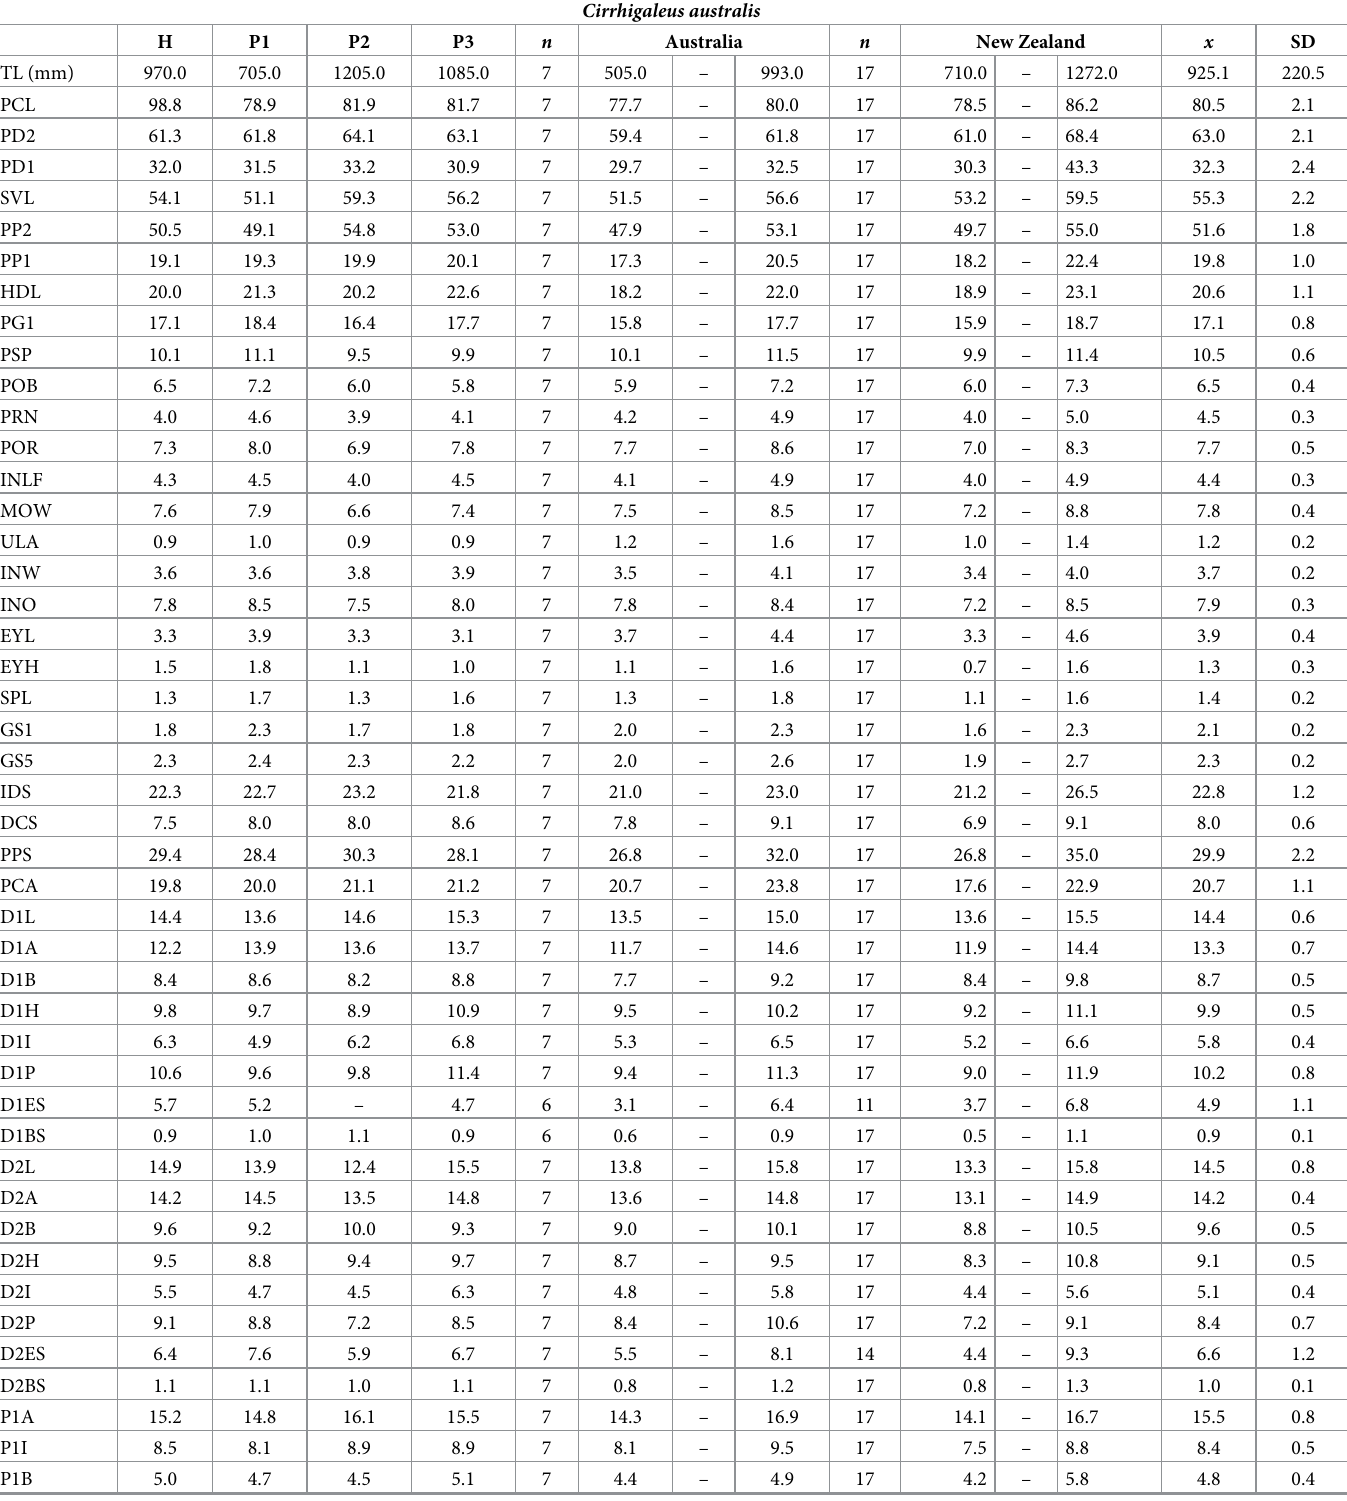
Table 3. External measurements of C . australis expressed as percentage of total length